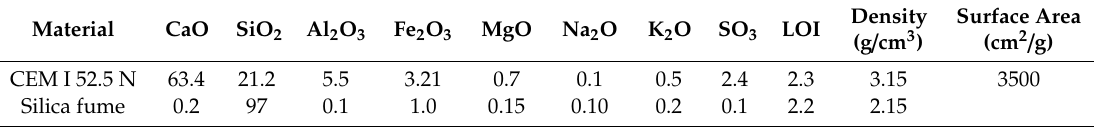
Table 1. Physical properties and chemical composition used fine materials.